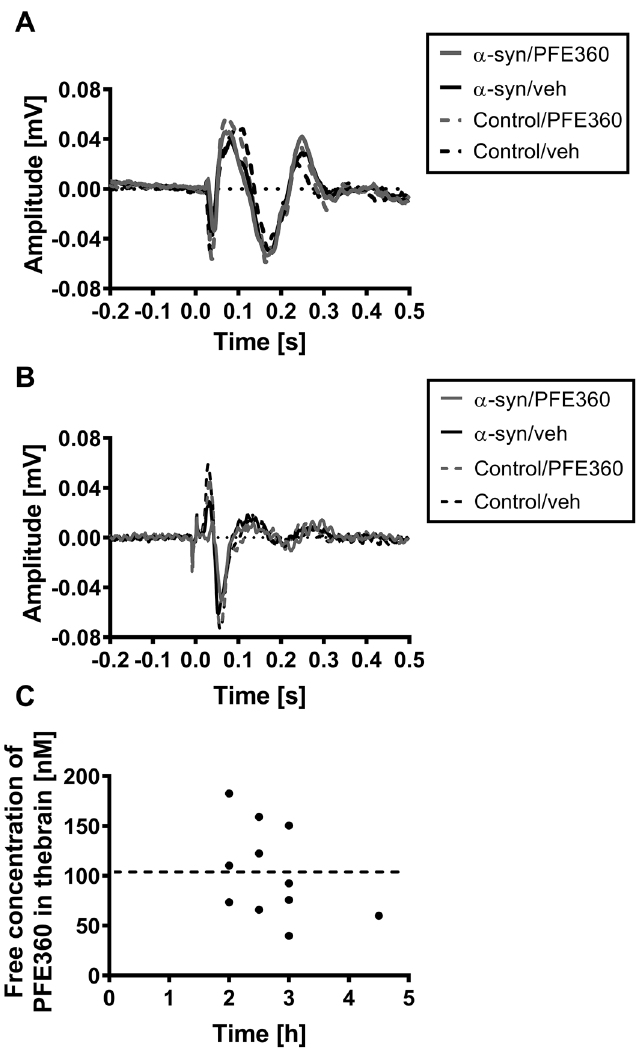
AAV vector (dashed lines). Following this, they were treated with either vehicle (black) or the LRRK2 inhibitor PFE360 (grey). ( B ) Four superimposed VEP waveforms recorded from the SC. ( C ) Free concentration of PFE360 measured in the cerebellum of the rats, n = 11, 2–4.5 h after PFE360 administration. X-axis shows time since administration in hours. The broken line indicates the mean